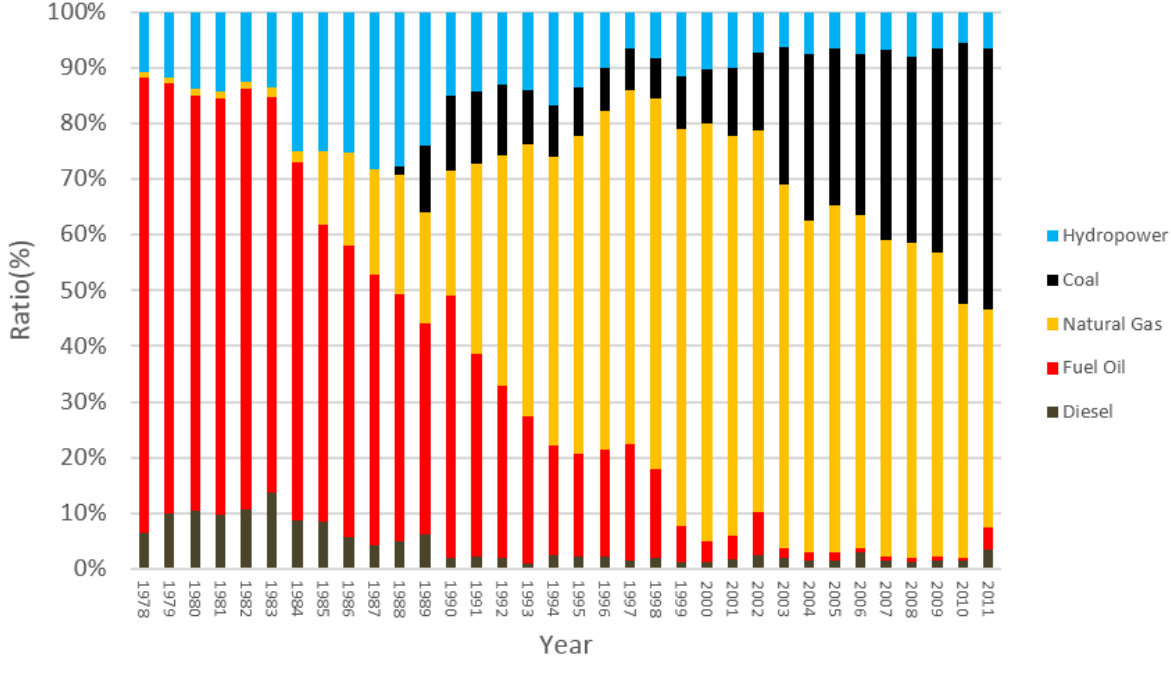
Figure 29. The structure of fuel consumption in Malaysia’s power plants from 1978 to 2011.